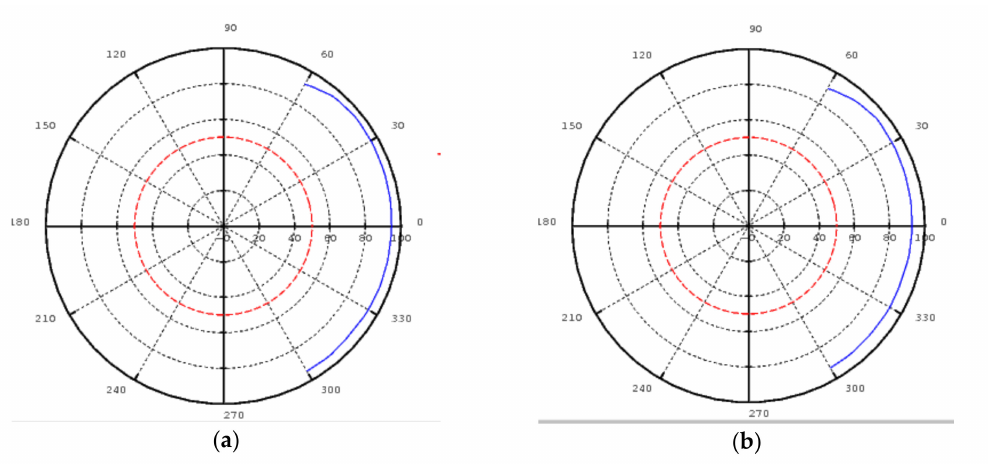
Figure 11. Result of Guth VCP simulation for overcast sky conditions: ( a ) wire skylight glazing; ( b ) di ff use skylight glazing.